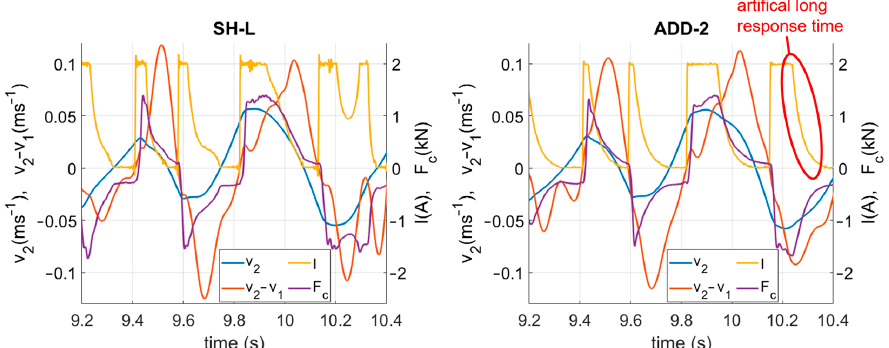
10 of 14 Figure 7. Damper force drop response time 𝜏 (cid:2871)(cid:2874) effect for passive mode, SH-2 and SH-L algorithms ( left ) and passive mode, ADD-2 and ADD-L algorithms ( right ), HILS results. For SH-2 and SH-L algorithms, the response time for the damping force drop is sig- nificantly more critical than for the damping force rise. It is caused by the input electric